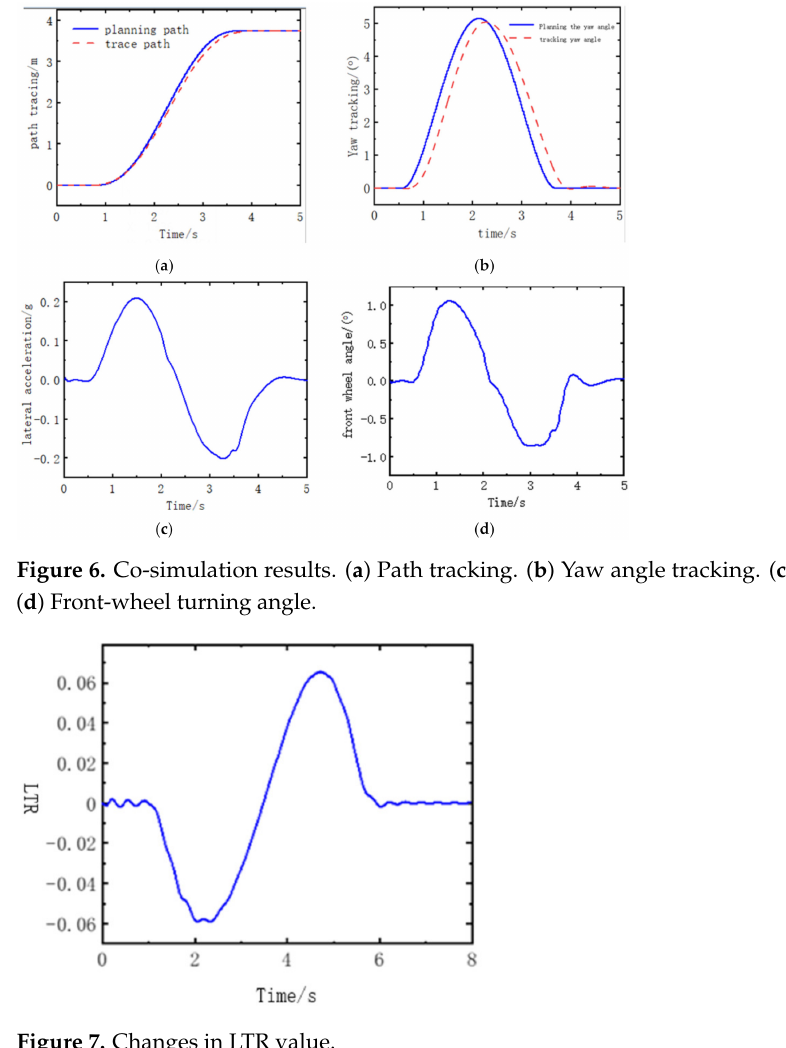
Figure 7. Changes in LTR